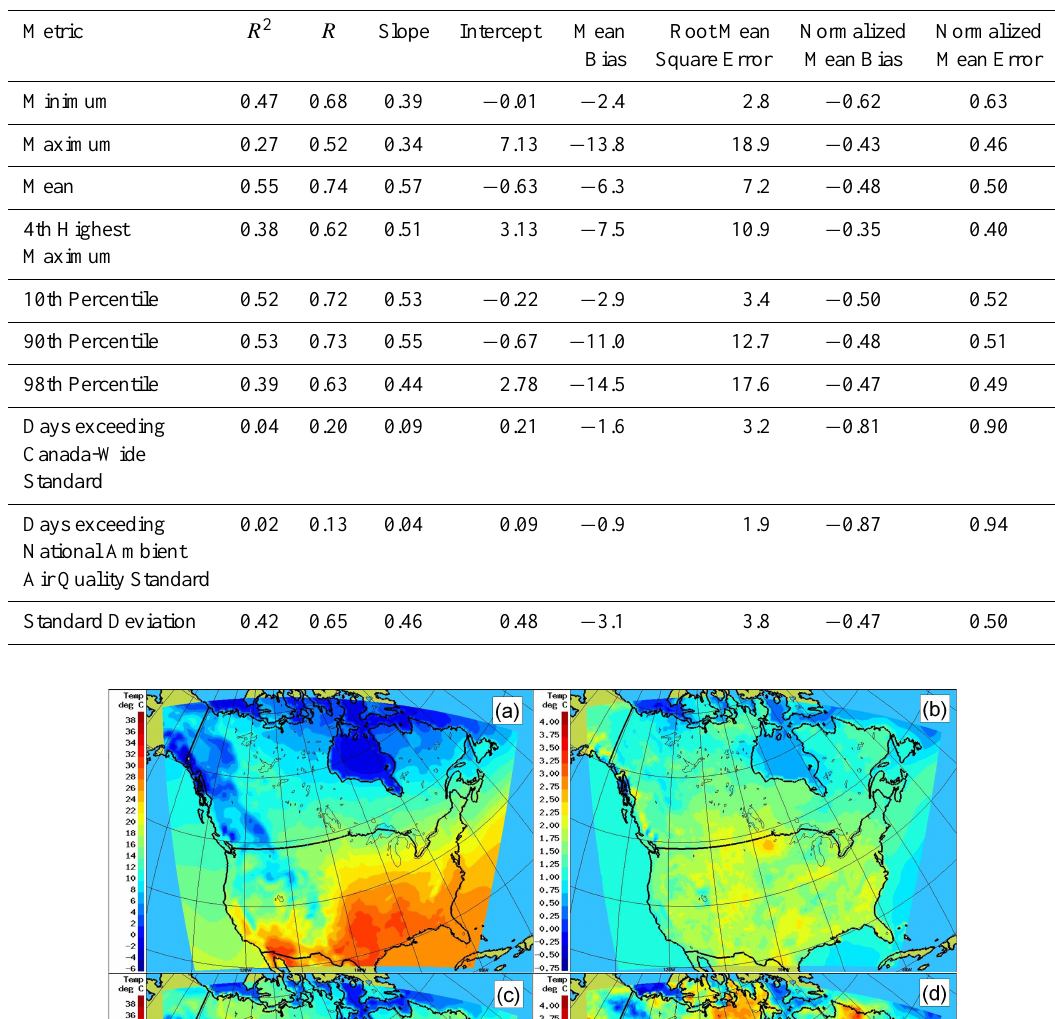
Table 4. AURAMS-CRCM Performance Statistics for “Current” scenario: PM 2 . 5